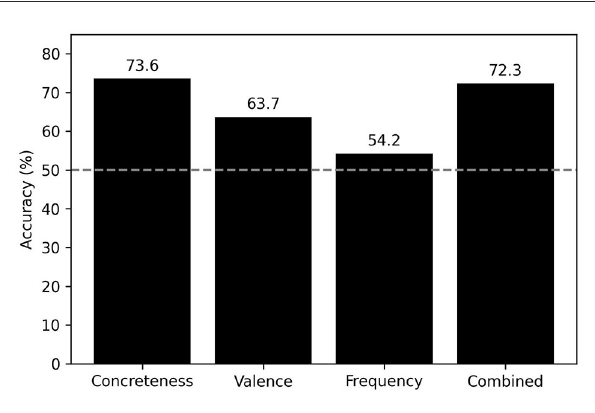
FIGURE2 Predictive accuracy of concreteness, frequency, and valence in inferring directionality of semantic change. “Combined” refers to the logistic regression model that combines the three variables. Dashed line indicates chance accuracy (50%).